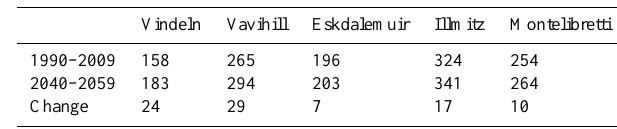
Table 3. Average length of the O 3 sensitive period (O 3 SP in days) relevant for coniferous and evergreen tree species during the two 20-year time periods 1990–2009 and 2040–2059 at the five sites representing different climate regions of